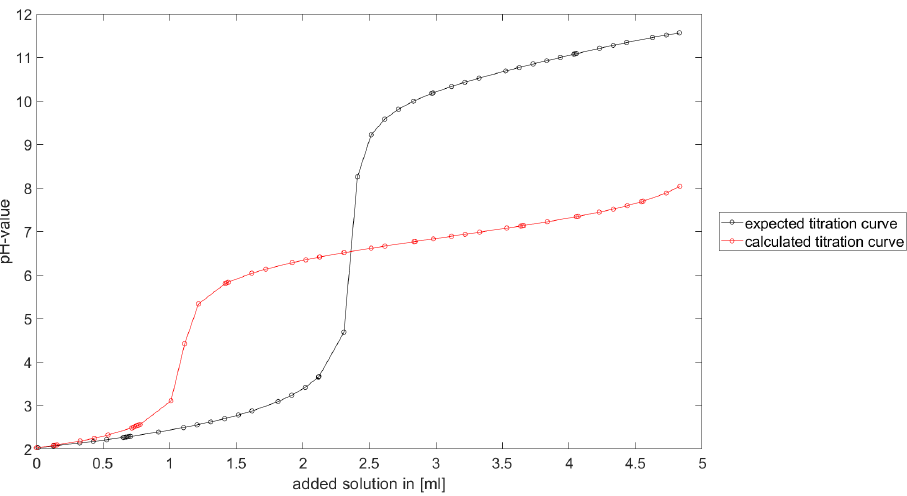
Figure 5. Titration curve with full (black), see Table 1, and reduced system of reactions (red), see Table